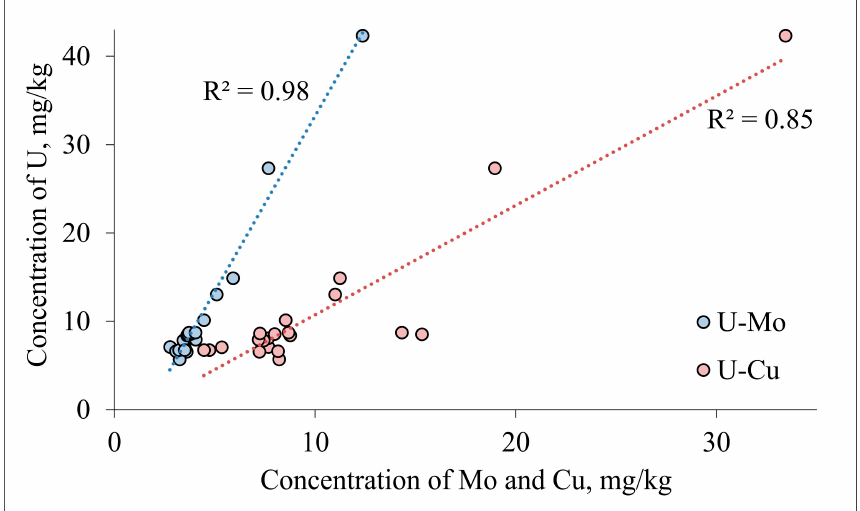
Figure 5. Correlation between the concentration of U and Mo, and U and Cu in the sediments of Lake Gryaznoe.